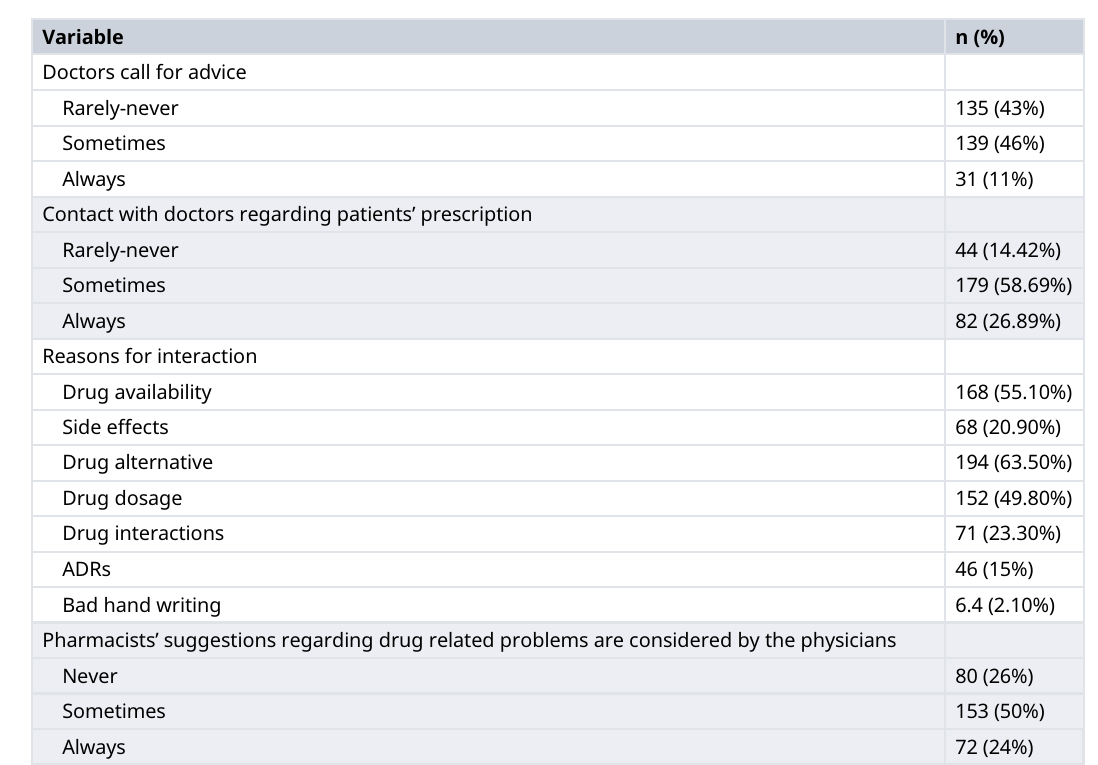
Table 2. Interaction with doctors on patients ’ medication.